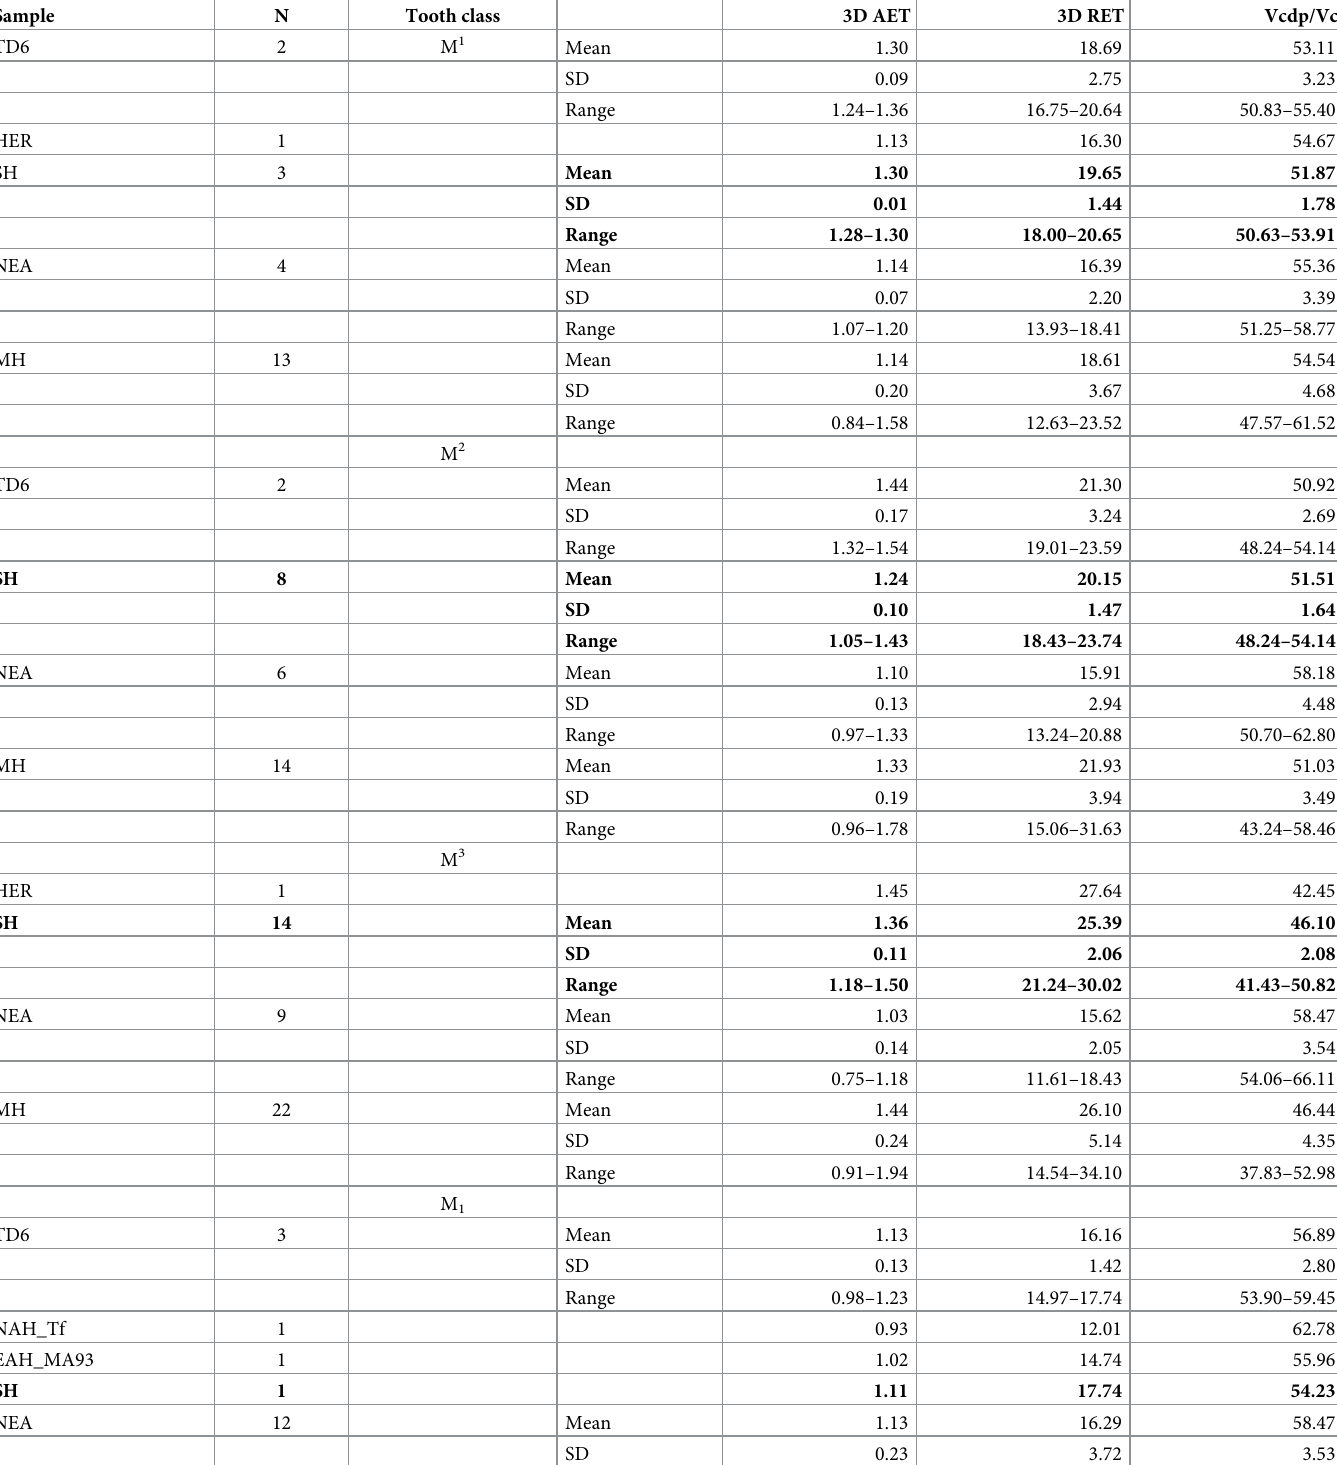
Table 4. 3D enamel thickness, complete crown, variables assessed in SH maxillary and mandibular molars and compared with extinct and extant specimens/popula- tions (SH data in bold). Mean and range are given for the comparative sample when having more than two specimens. Individual values are given for the rest of compara- tive